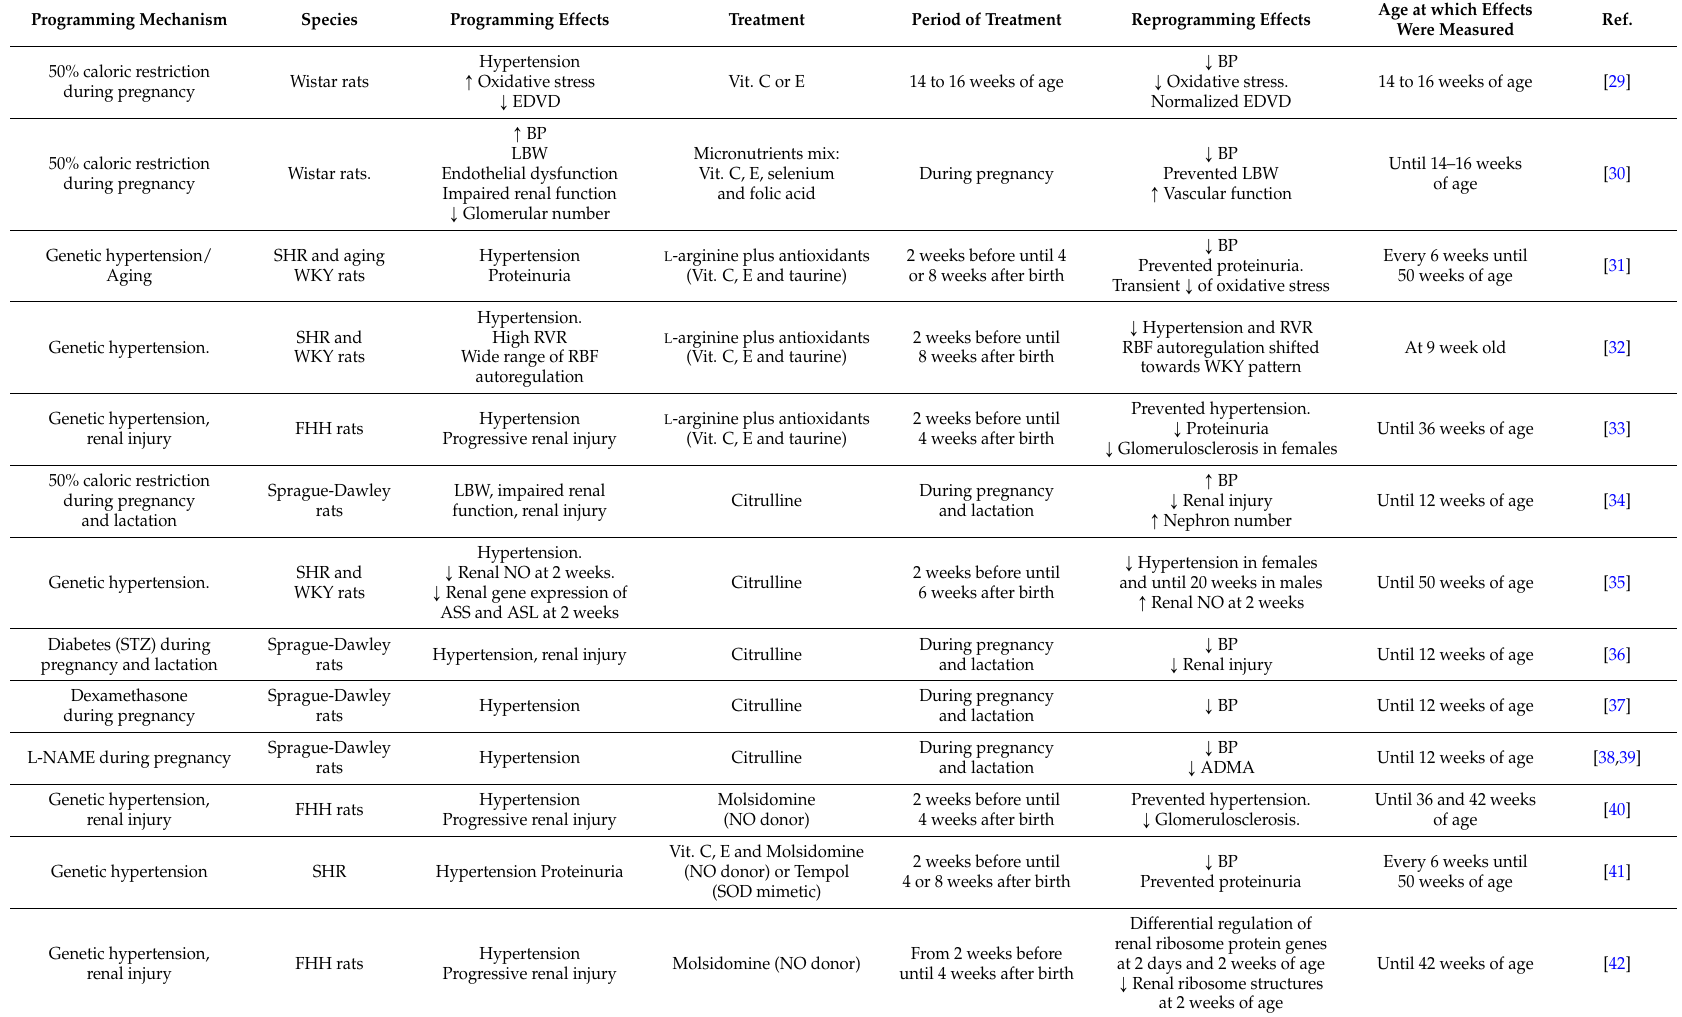
Table 2. Reprogramming aimed at shifting the NO-ROS balance in developmentally acquired and genetic hypertension